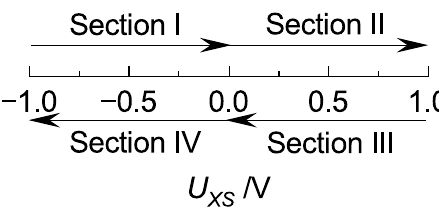
Figure 10. Visualization of Section I, II, III, and IV respectively to Table